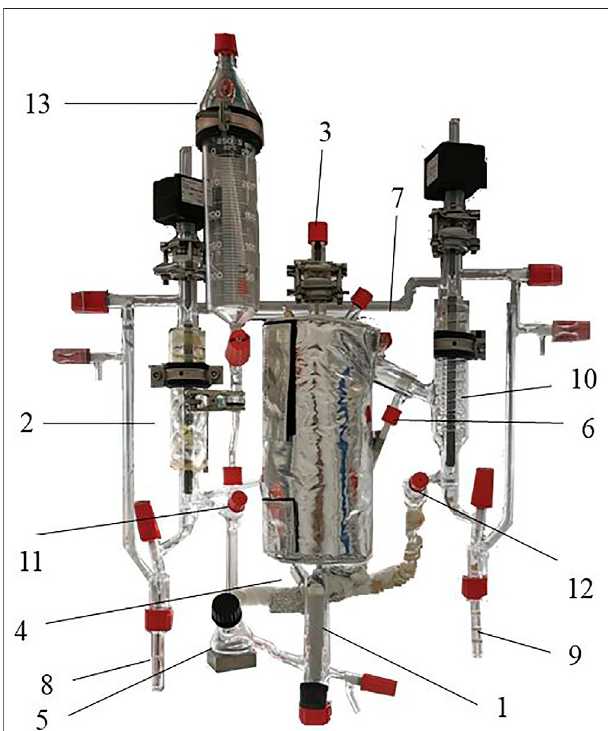
FIGURE 1 | Apparatus FISCHER ® LABODEST ® VLE 602 used in this work. 1: Reservoir with immersed rod heater. 2: Condenser. 3: Vapor-phase temperature sensor. 4: Liquid-phase temperature sensor. 5: Mixer chamber. 6: Coolant water connection. 7: Pressure control line. 8: Liquid sampling port. 9: Vapor sampling port. 10: Condenser. 11: Liquid-phase septum. 12: Vapor-phase septum. 13: Side